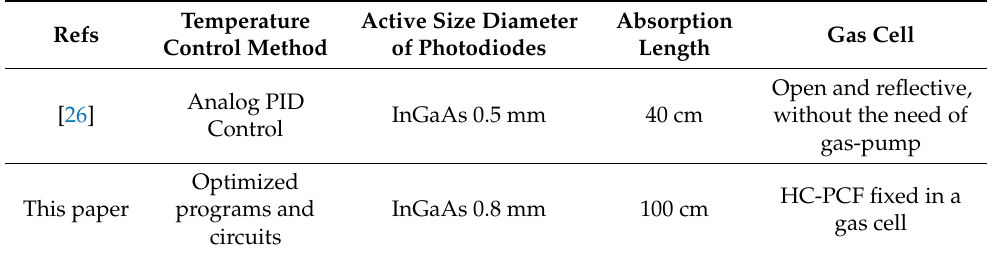
Table 1. Comparison between the proposed system and the previous